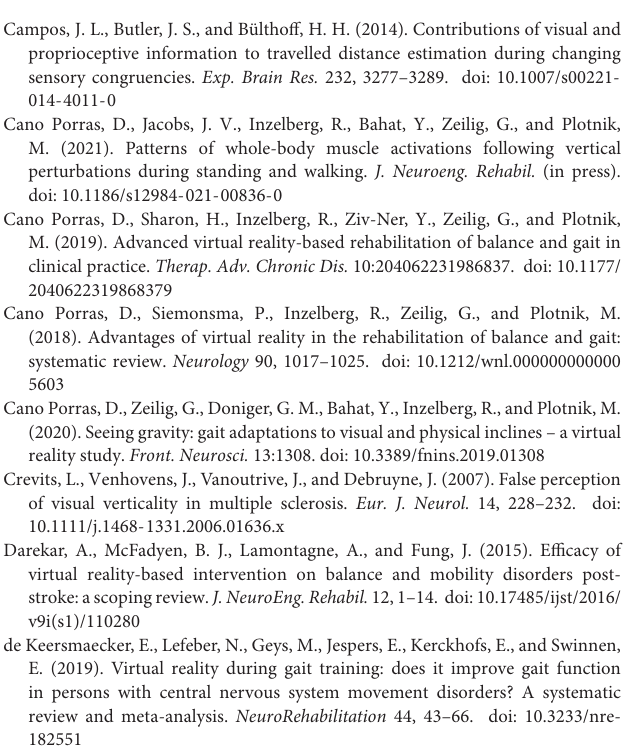
(SSV). On these traces, the peak/trough were identified (green arrows), and the time from transition was calculated (gray line). Units used for magnitude were the relative change (%) in comparison to the SSV values. The second parameter is the time of maximal change. Supplementary Figure 2 | A graphical representation of the right gastrocnemius (GCR) muscle from 24 gait cycles obtained from one participant during the T U V U